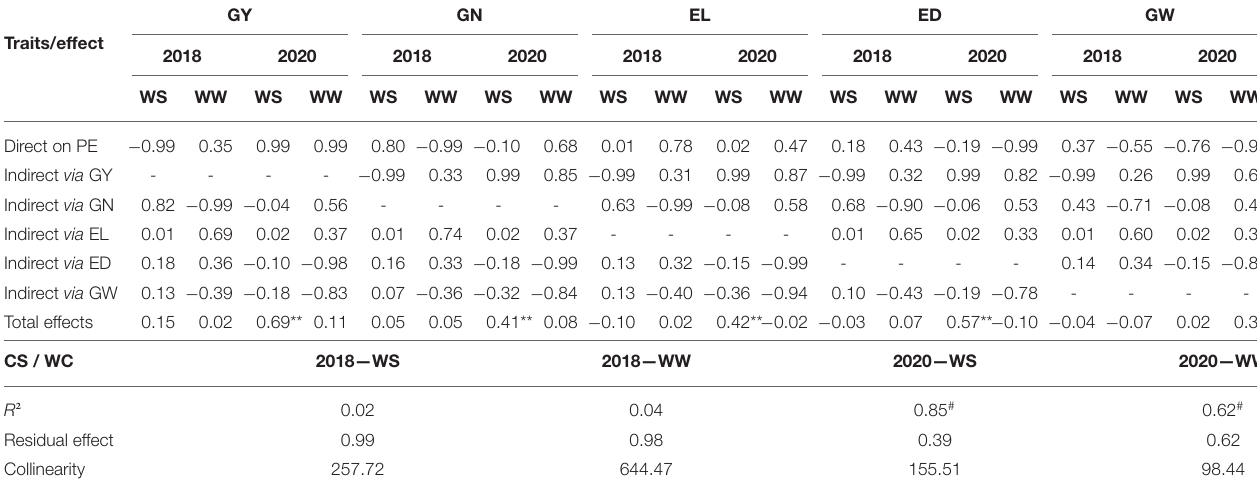
TABLE 7 | Path analysis of the partitioning of genotypic correlations into components of direct and indirect effects, a collinearity test, coefficient of determination, and residual effect obtained between PE and agronomic traits evaluated in popcorn genotypes under WS and WW conditions in the crop seasons of 2018 and 2020.